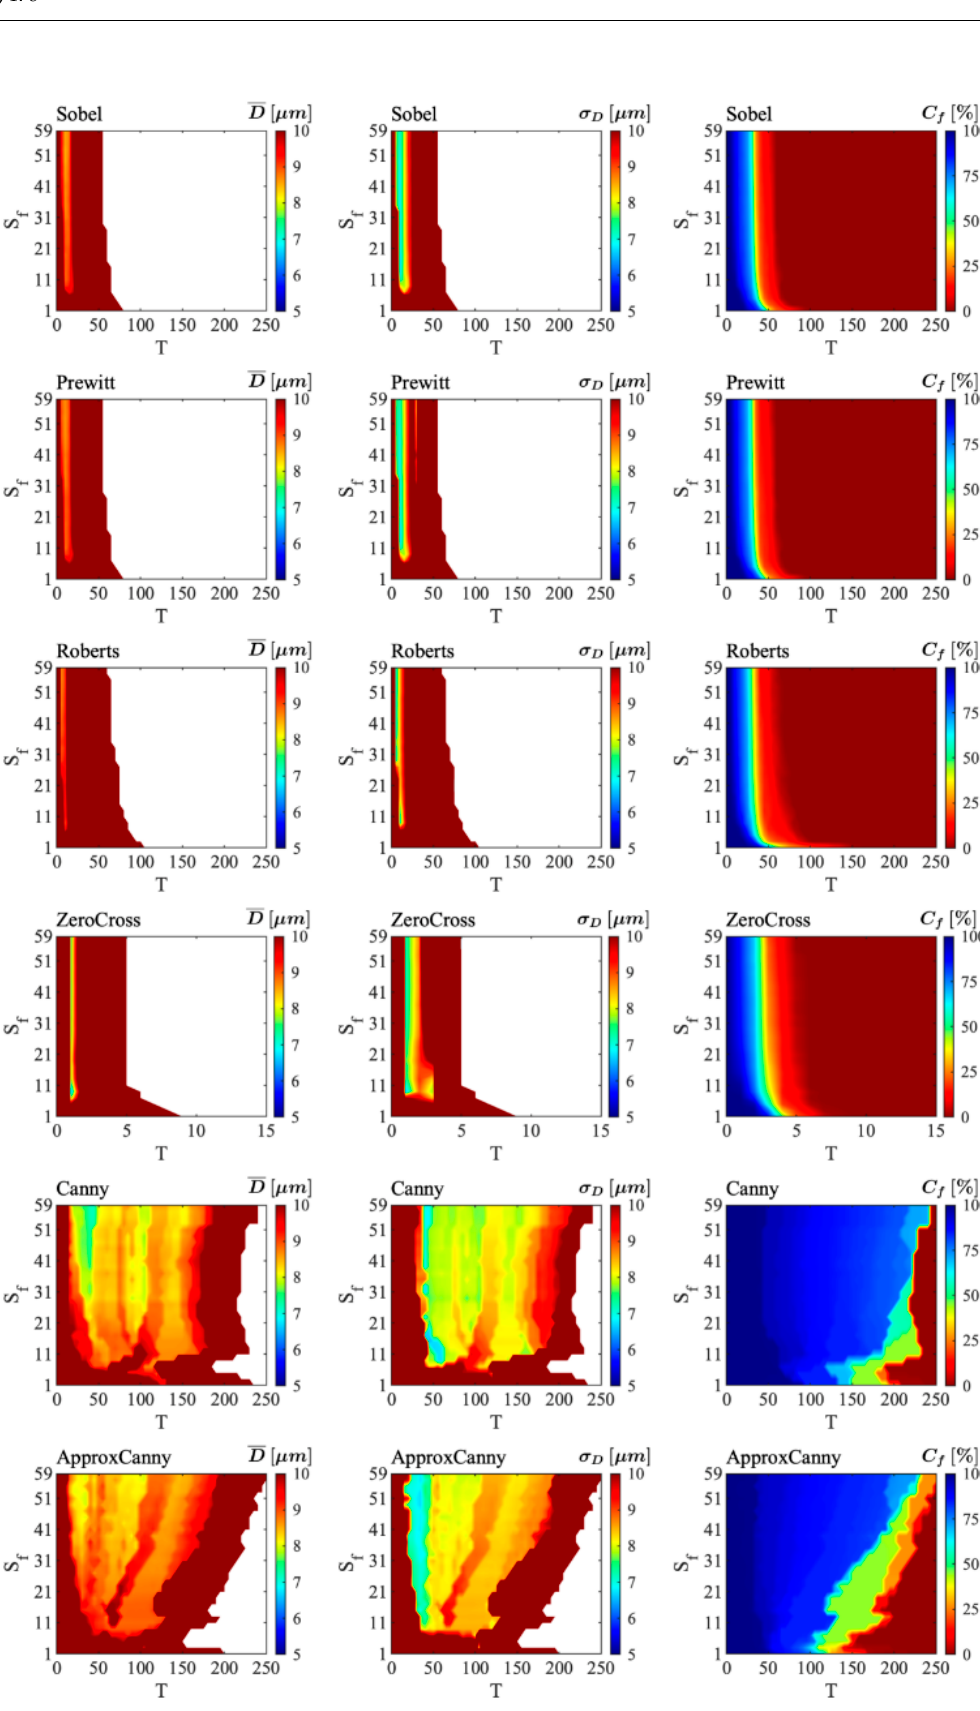
Figure 9. MQI results as a function of S f and T for every M calculated for SO